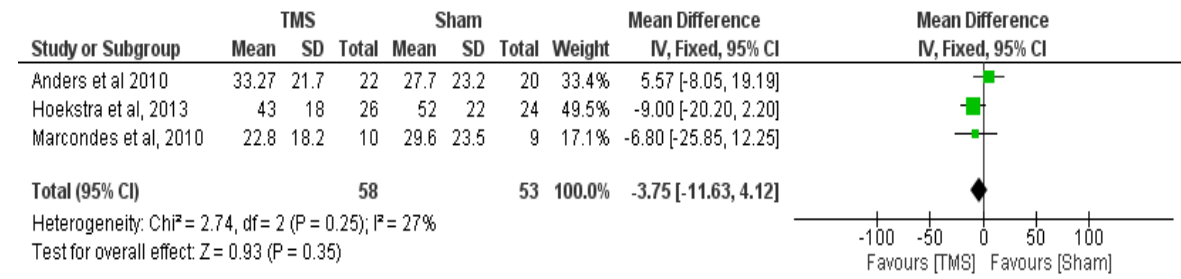
Table 2. Mean tinnitus handicapped inventory (THI) in 3 studies with similar design at baseline, directly after rTMS and after 6 months